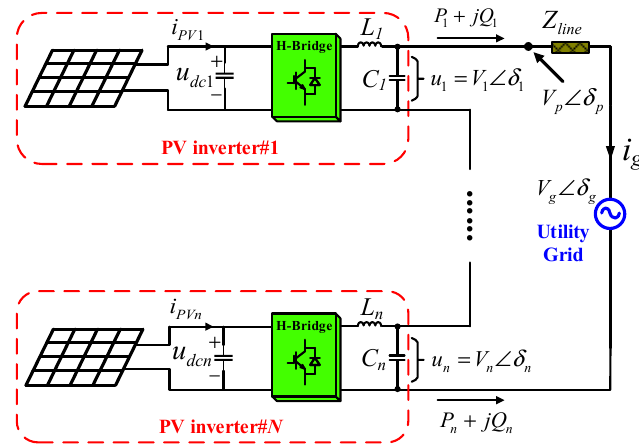
Figure 1. Configuration of AC-stacked photovoltaic (PV) inverter system.